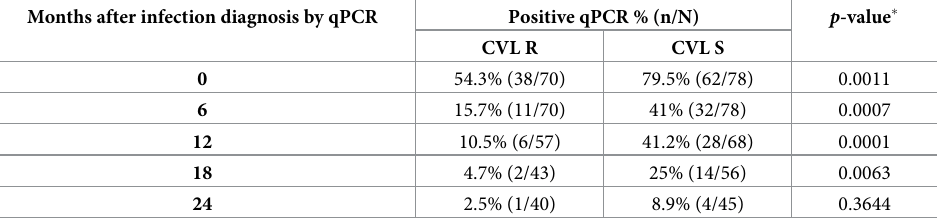
Table 4. Frequency of qPCR positive results employing spleen aspirates in visceral leishmaniasis resistant and susceptible dogs, during 24 months of follow-up. Months after infection diagnosis by qPCR